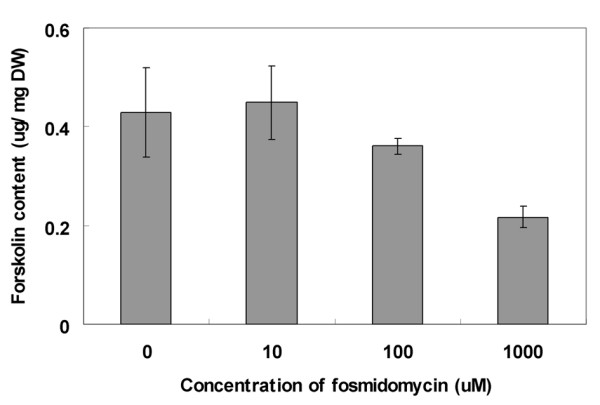
Effect of fosmidomycin on forskolin production.